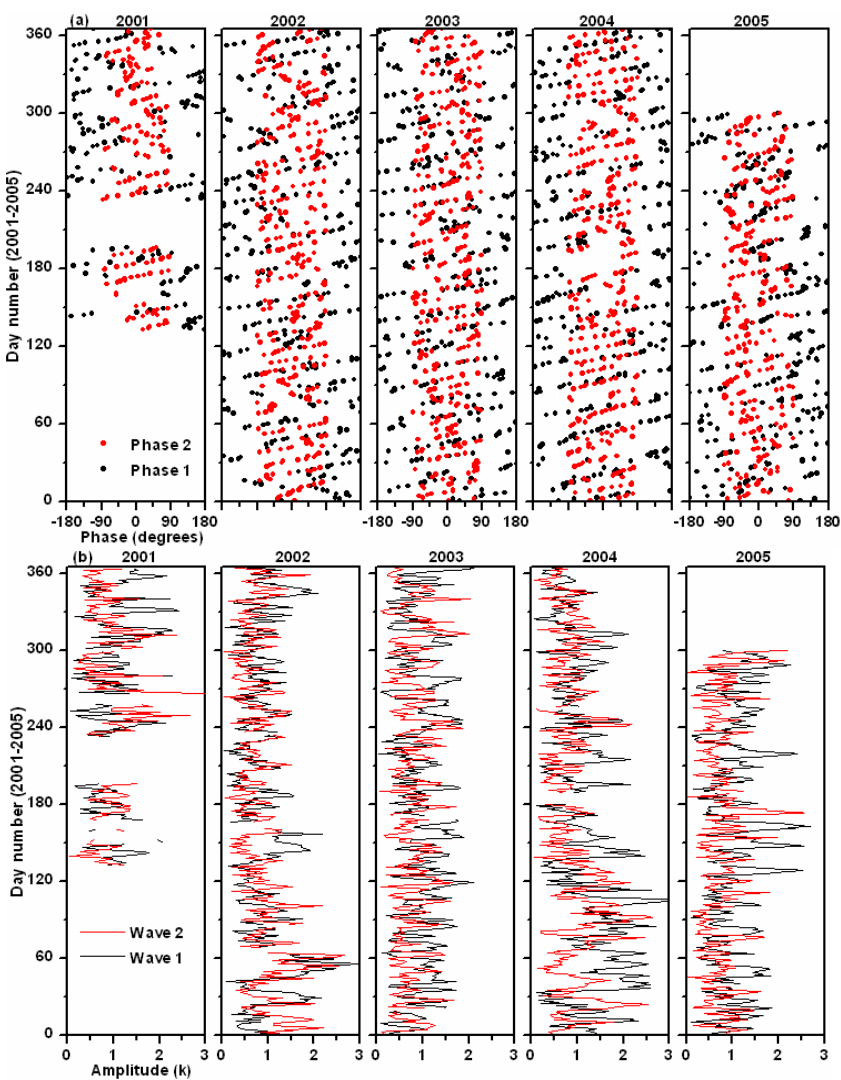
Figure 4. Long-term time series of (a) phases and (b) amplitudes of both wave numbers 1 (black) and 2 (red) observed using CHAMP/GPS observations at 20 km altitude region.